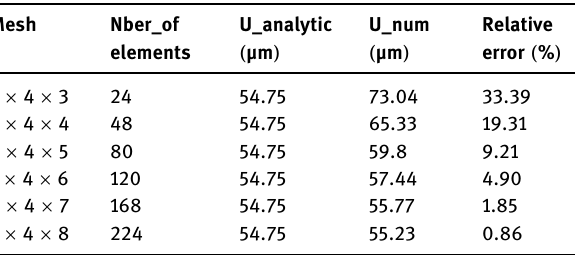
Table 2: Evolution of mid - surface displacement – numerical and analytical comparison Mesh